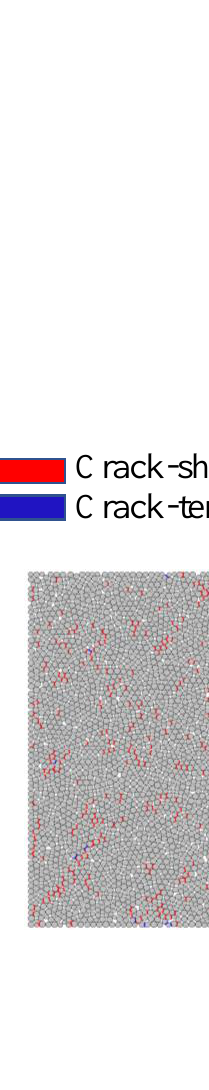
Table 3. Crack distribution at different temperatures.